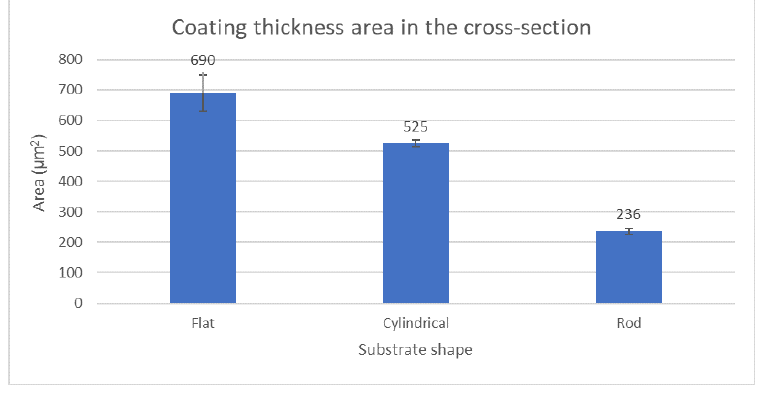
Figure 22. Cross-section surface area and standard deviation of coatings deposited on the flat, cylindrical and rod substrates.